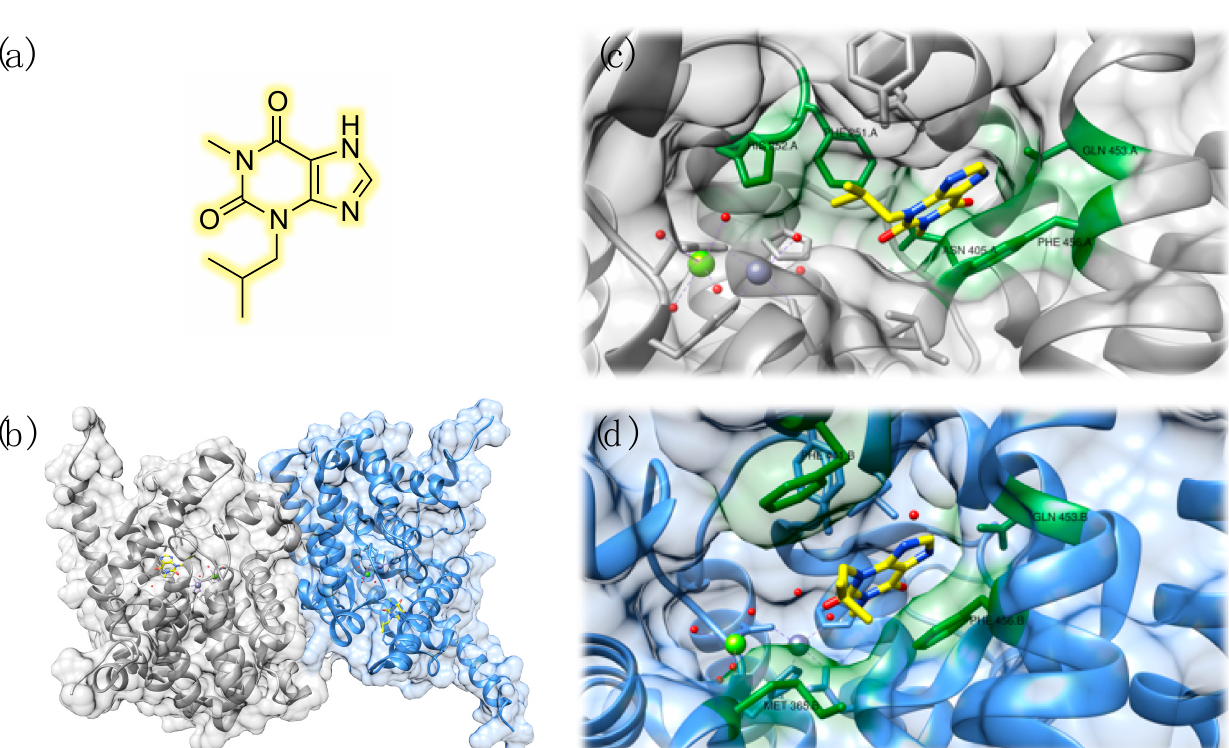
Figure 2. Chemical structure of 3-isobutyl-1-methylxanthine (IBMX) ( a ). Three-dimensional structure of PDE9 in complex with its inhibitor IBMX, highlighted in yellow (PDB ID: 2HD1): chain A is depicted in grey and chain B in blue ( b ). Detailed view of the interaction pattern of IBMX with chain A: zinc is represented in purple and magnesium is reported in green. Interacting residues have been labeled and highlighted in green ( c ). Detailed view of the interaction pattern of IBMX with chain B: zinc is represented in purple and magnesium is reported in green. Interacting residues have been labeled and highlighted in green ( d